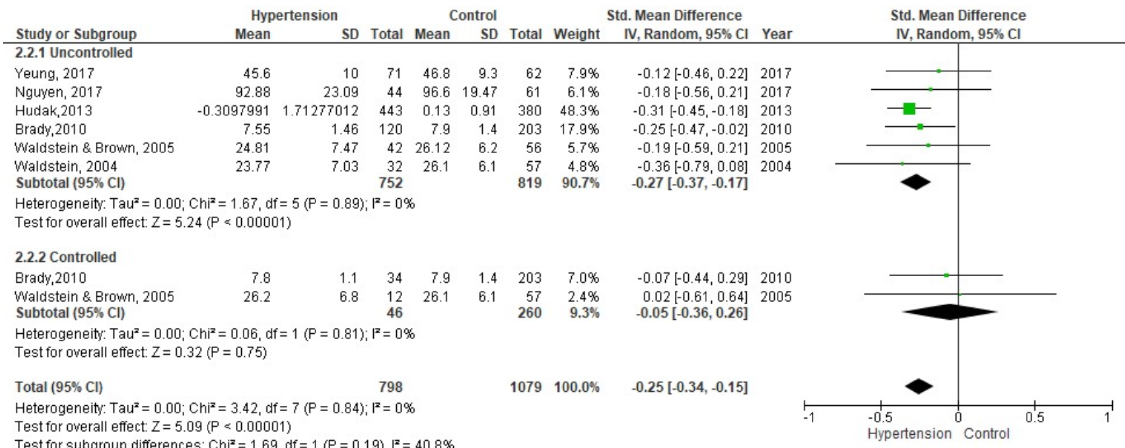
Figure 4. Meta-analysis on the comparison of groups with controlled and uncontrolled hypertension between the control group in short-term memory y